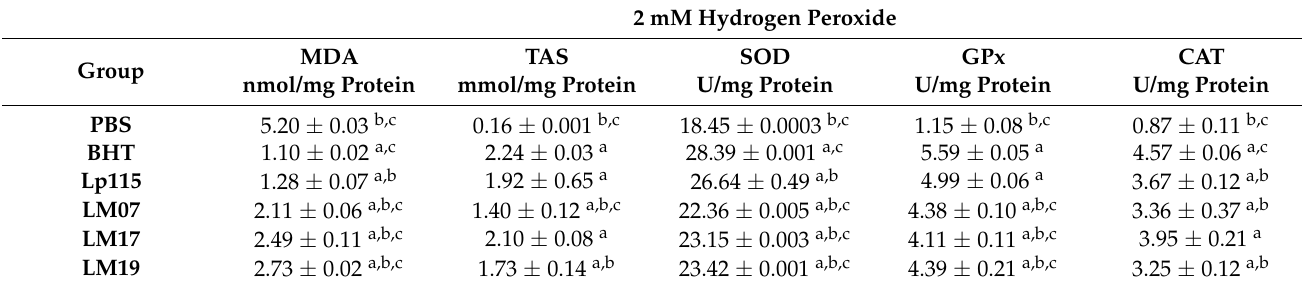
Table 3. Effects of Lactobacillus co-cultured with colonic cells HT-29 under oxidative stress with hydrogen peroxide.